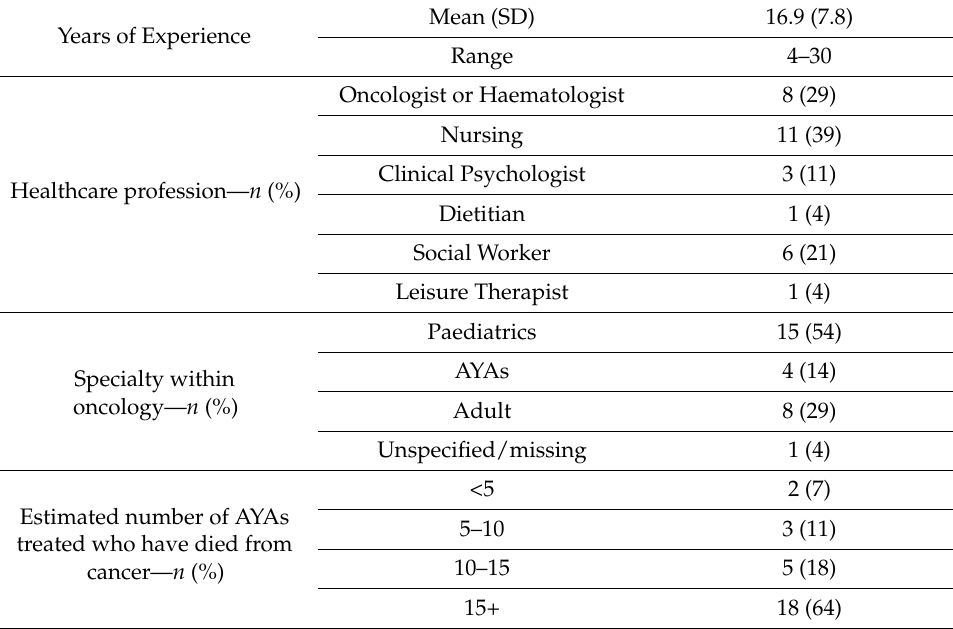
Table 3. Characteristics of health professional participants ( n =